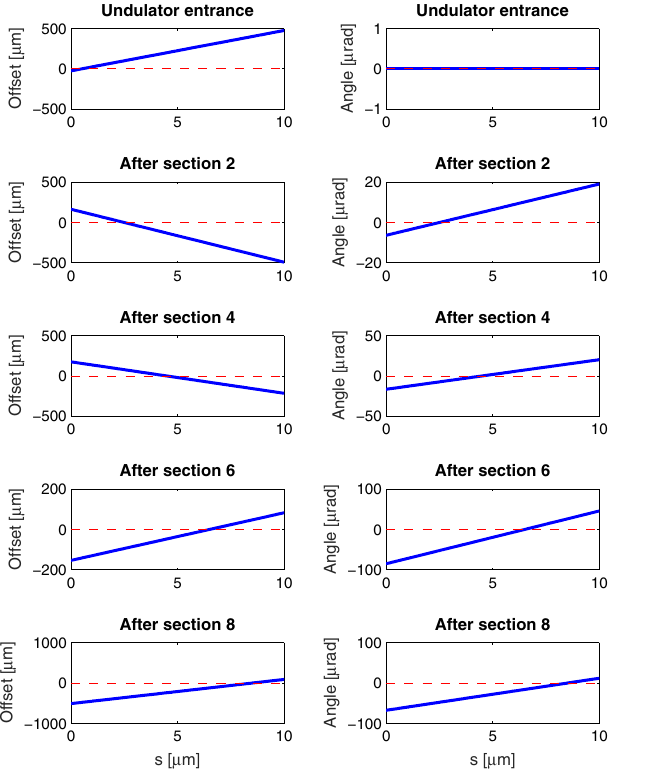
FIG. 3. Trajectory offset (left plots) and angle (right plots) as a function of the longitudinal position of the bunch at the undulator entrance (top plots) and after every other undulator section for the case of an initial tilt amplitude in offset of 50. The blue solid lines indicate the tilt and the red dashed lines show for reference the aligned trajectory. The horizontal axis corresponds to longi- tudinal position along the bunch in all plots. The trajectory correction at the exit of each section can be performed with the first and last dipole magnets of the magnetic chicane used also to delay the electron beam (see text for more details). The phase advance per undulator module is about 30 degrees.